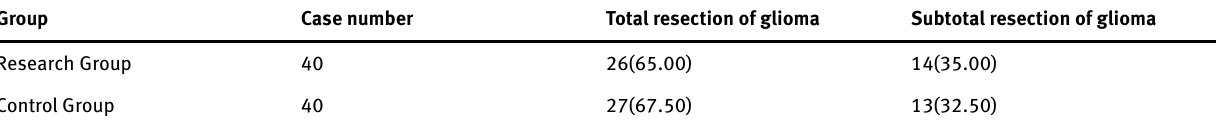
Table 2 Comparison of resection situation of lesion between patients of the two groups (Case /%) Group